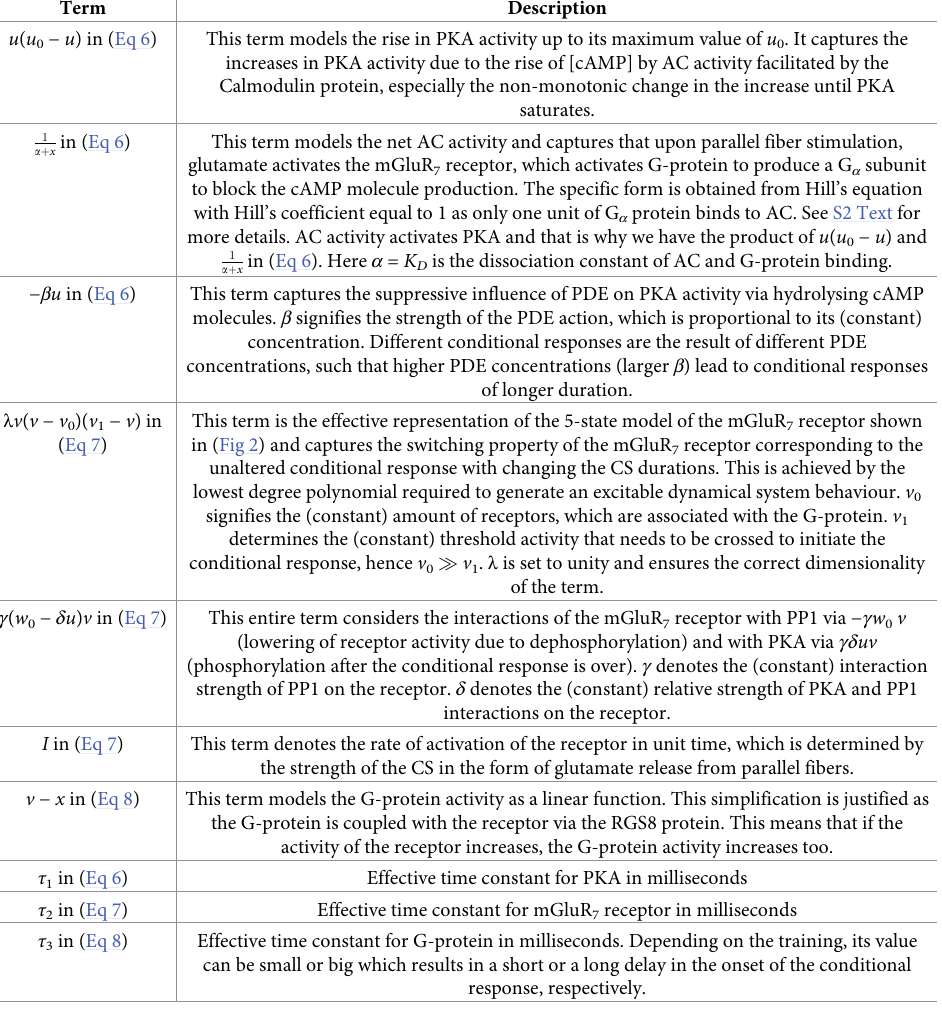
Table 1. Description of the various terms in the minimal model. Term